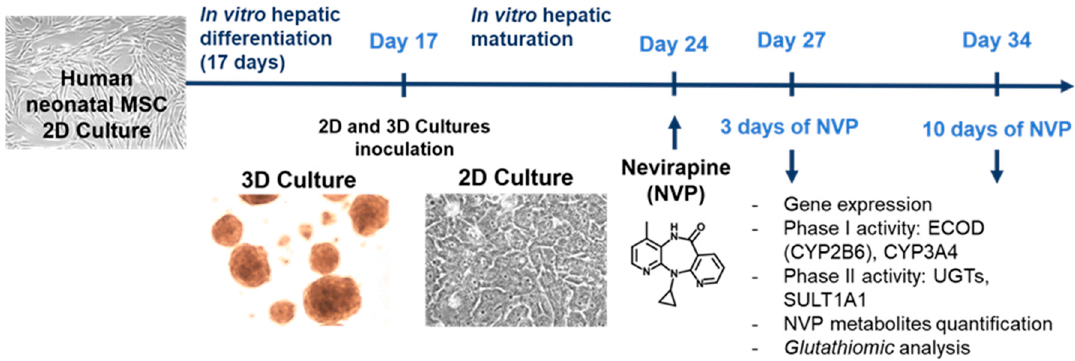
Figure 7. Schematic representation of the study design.